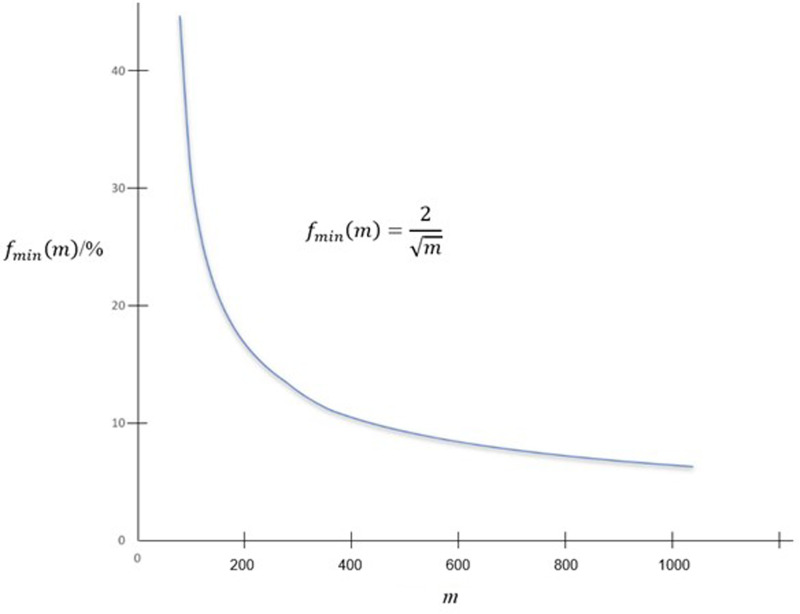
fmin(m) against m.